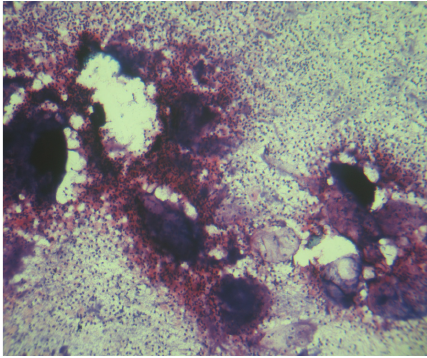
Figure 3: Photomicrograph of smear (10x) Gram’s staining image of actinomycotic colony with peripheral neutrophilic